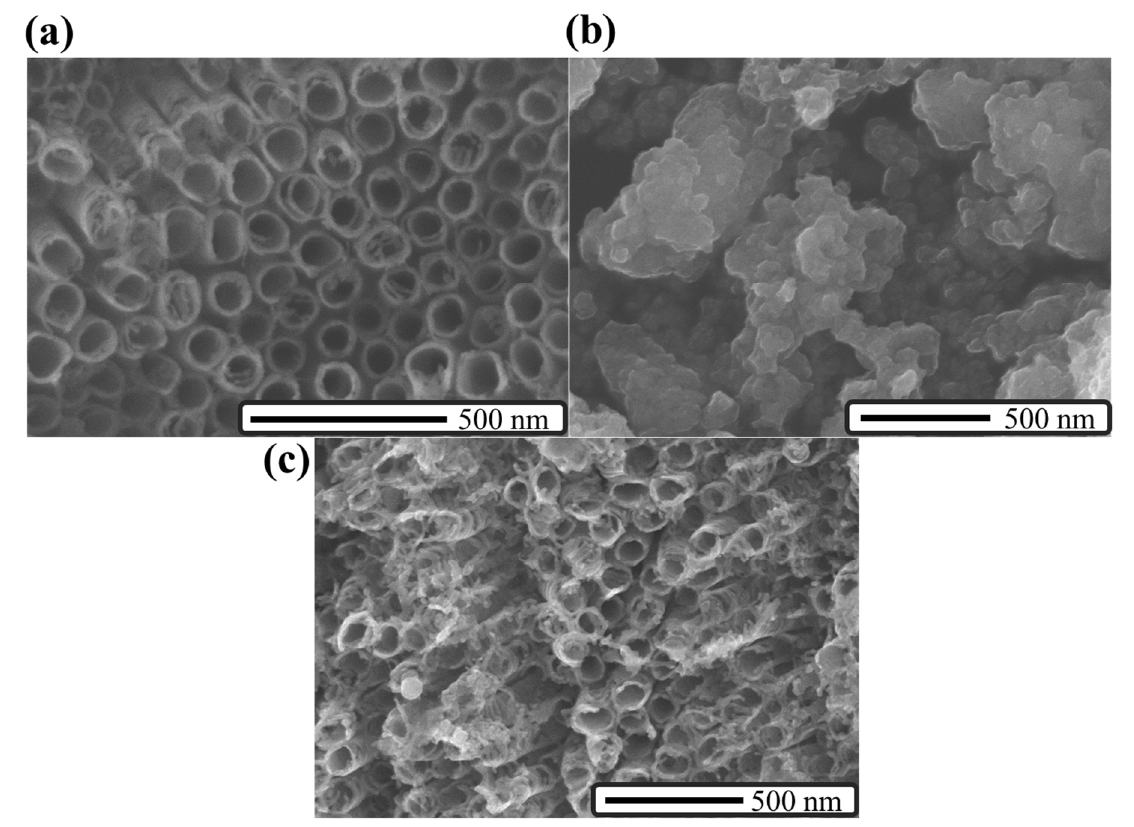
Figure 4. SEM images of TNAs ( a ), MoS 2 ( b ), and MoS 2 @PVA/TNAs@140 ( c ). The LSV of the materials is measured to evaluate the PEC performance. The pho- toresponse ability of the materials was then evaluated with an applied potential at 0 V vs. Ag/AgCl. Figure 5a shows that the current density of TNAs versus applied potential is higher under visible light than that of dark conditions. In detail, the onset potential of TNAs is obtained at − 0.42 V vs. Ag/AgCl in the dark, while it is achieved at − 0.55 V vs. Ag/AgCl with the highest current density (11.2 µ A) under visible light. Besides, the LSV results of MoS 2 in both dark and light conditions are not significantly different. The onset potential was obtained at − 0.2 V vs. Ag/AgCl. On the other hand, the combination of MoS 2 and TNAs with a cPVA binding agent indicated an efficient result for OER ability compared to other materials such as TNAs, MoS 2 , and cPVA (Figure S2). In detail, the onset potential of the MoS 2 @PVA/TNAs@140 sample is obtained at around − 0.78 V vs. Ag/AgCl. A current density slope increases from − 0.54 V vs. Ag/AgCl and readily reaches saturation at around 0.25 V vs. Ag/AgCl with a current density of about 83.4 µ A/cm 2 . Furthermore, Figure 5b shows that the photoresponse ability of MoS 2 is the lowest, with a different current density between dark and light conditions of just about 1.0 µ A/cm 2 . In contrast, the current density of TNAs is around 11.0 µ A/cm 2 , but it is not stable after five cycles. Specifically, the current density of MoS 2 @PVA/TNAs@140 surpasses 65.0 µ A/cm 2 at 0 V vs. Ag/AgCl in the first cycle of visible light irradiation, which is double that of MoS 2 /TNAs@140. Moreover, even after five cycles of “on-off” visible light irradiation, the photoresponse ability of the MoS 2 @PVA/TNAs@140 sample was highly stable. In addi- tion, the enhanced PEC water splitting potential window of the MoS 2 @PVA/TNAs@140 composite for the Na 2 SO 4 electrolyte is also indicated as Figure S3.